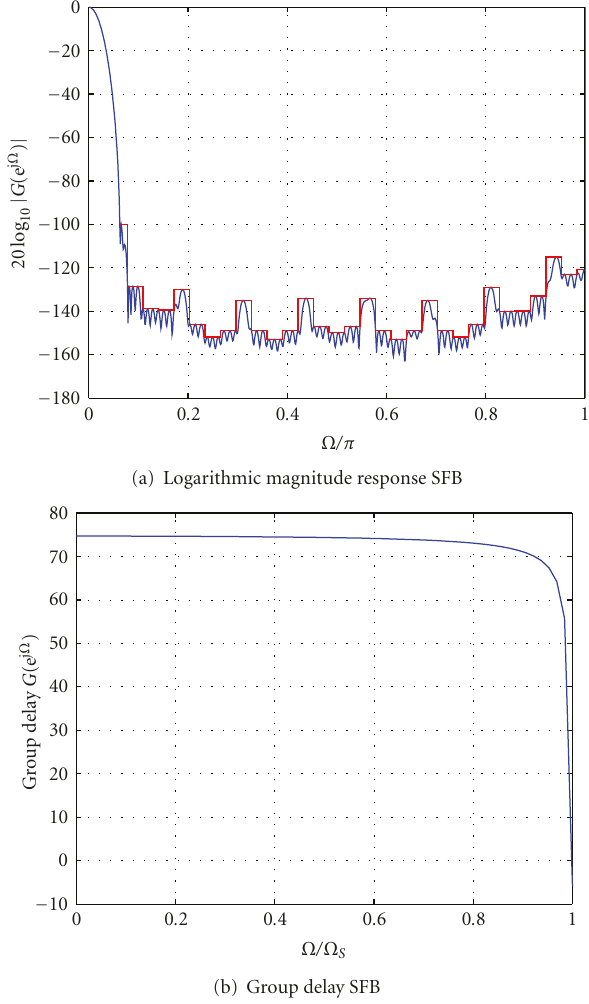
Figure 4: Narrow-band SFB prototype